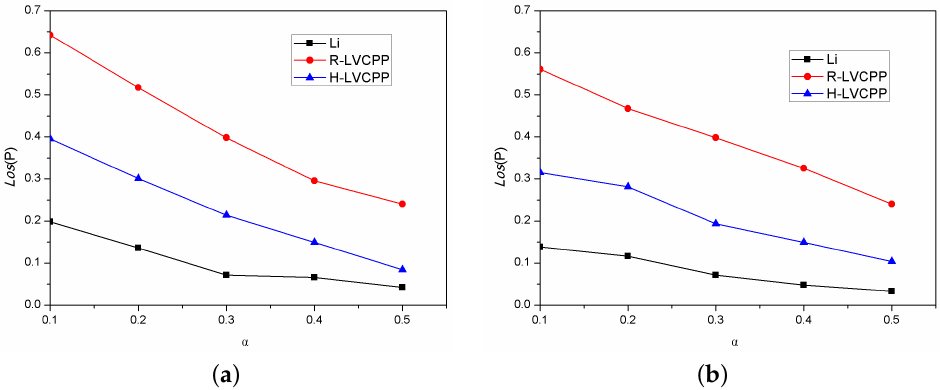
Figure 7. Pattern loss evaluation under different α : ( a ) Brightkite; ( b )